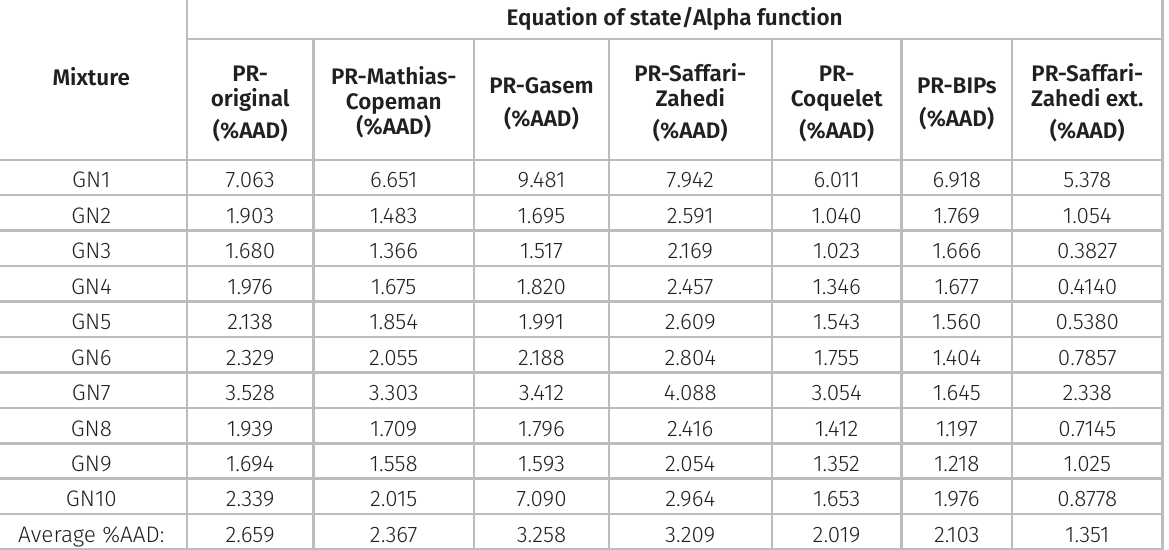
Equation of state/Alpha